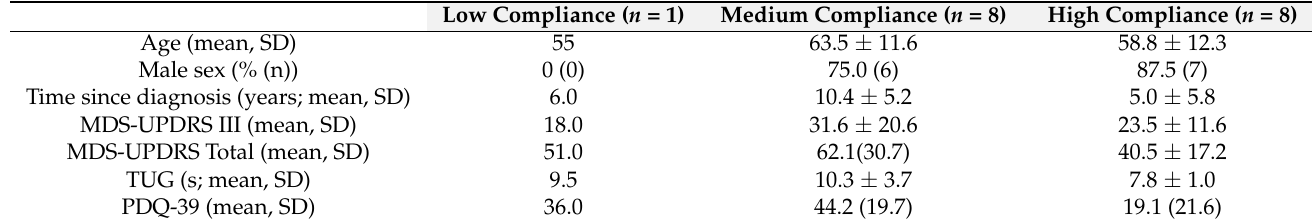
Figure 2. The average percent of compliance (per patient) with the daily survey and active tests (finger tapping, balance, and walk) during the 28 weeks (7 months) of the study, per day of the week, and per hour of the day. Expected data (100%) correspond to one survey per day and one active test per week. The survey notification was sent at 7:00 p.m. and remained available for 5 h. The gray shaded area identifies the COVID-19 confinement phase in Portugal. Table 4. Sample characterization per level of compliance